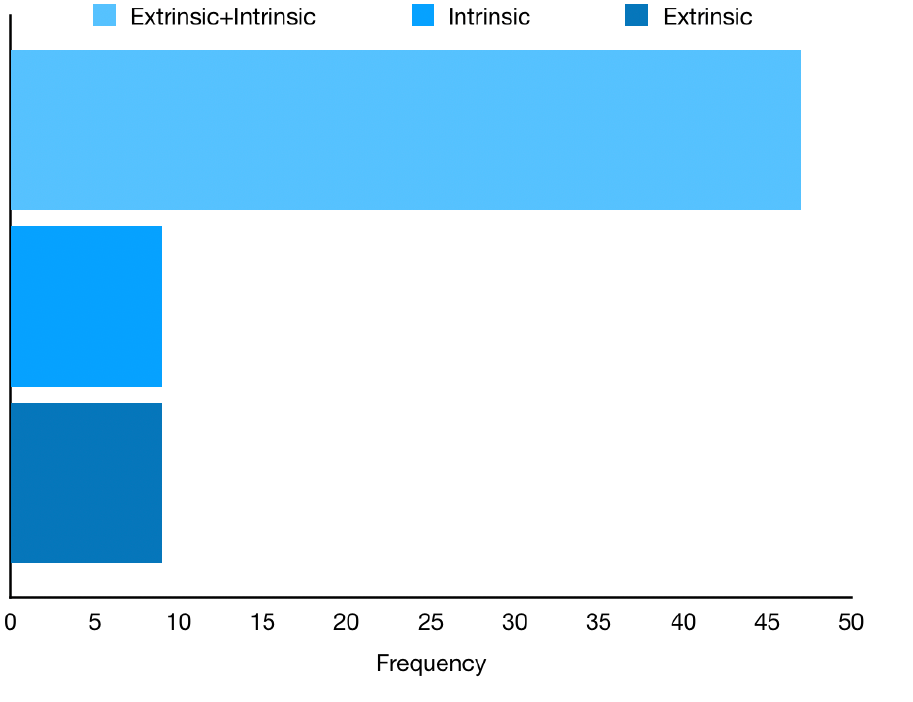
Figure 12. Histogram of feature selection and extraction categories used in selected PS.